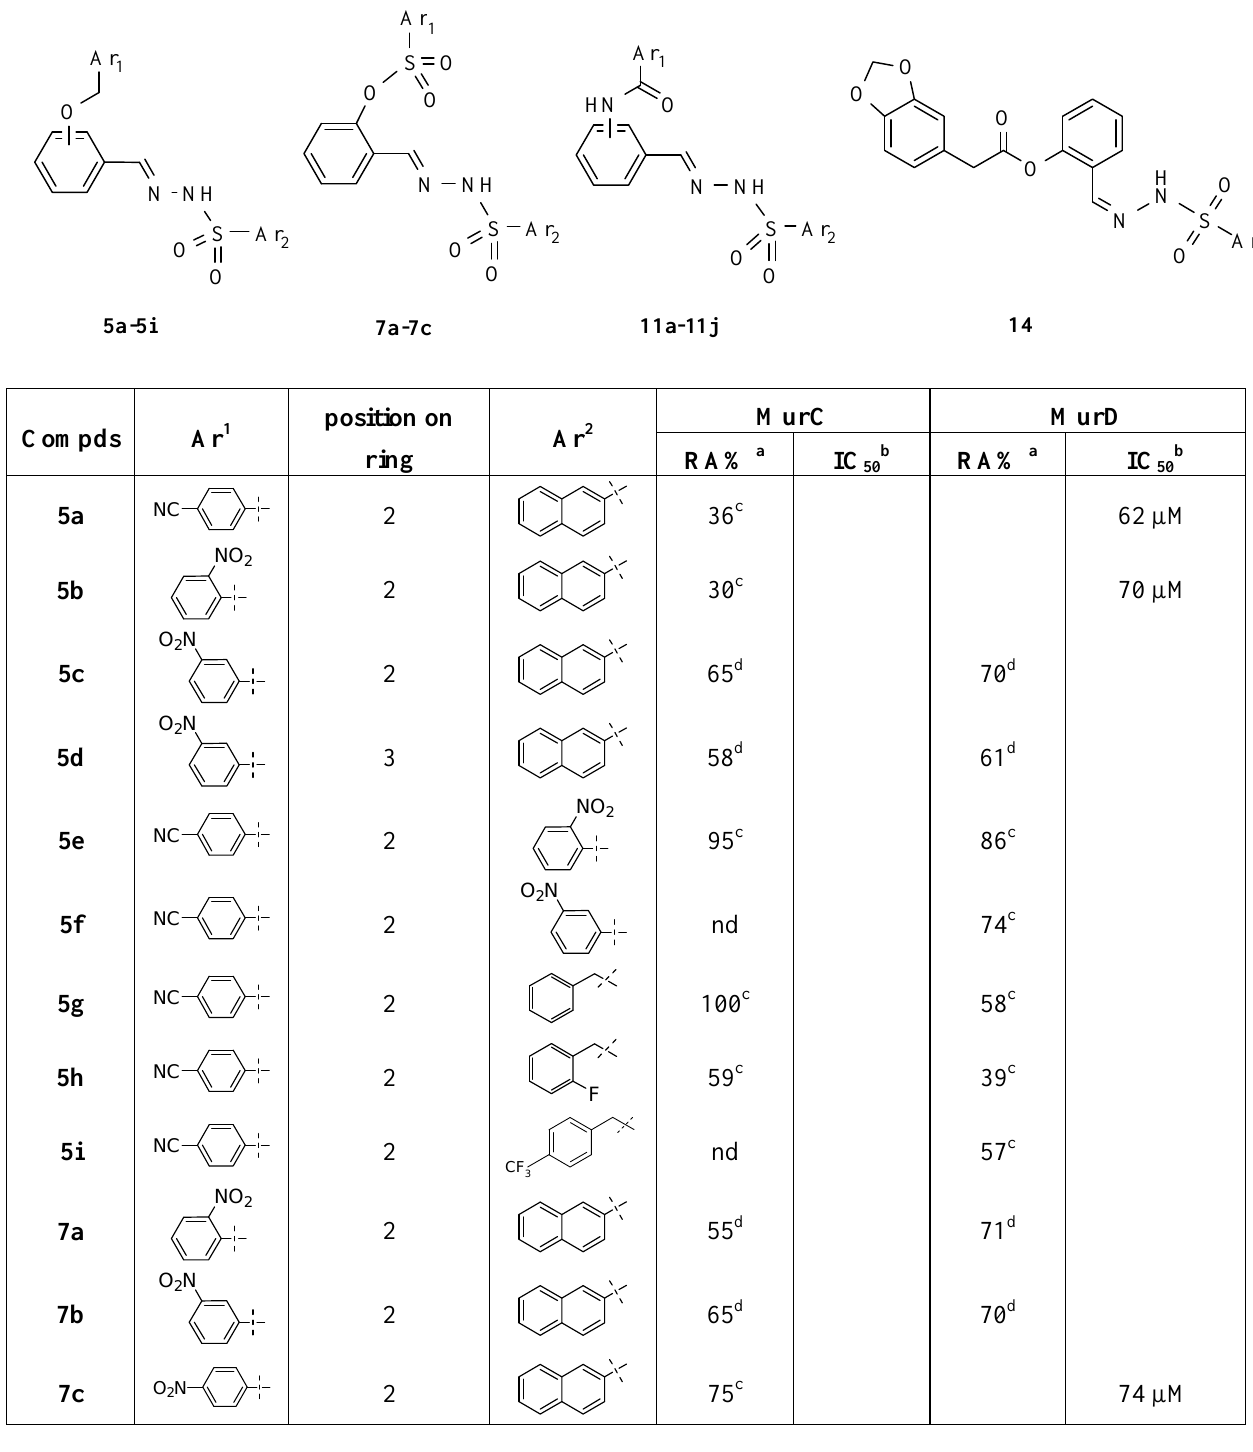
Table 1: In vitro inhibitory activity against MurC and